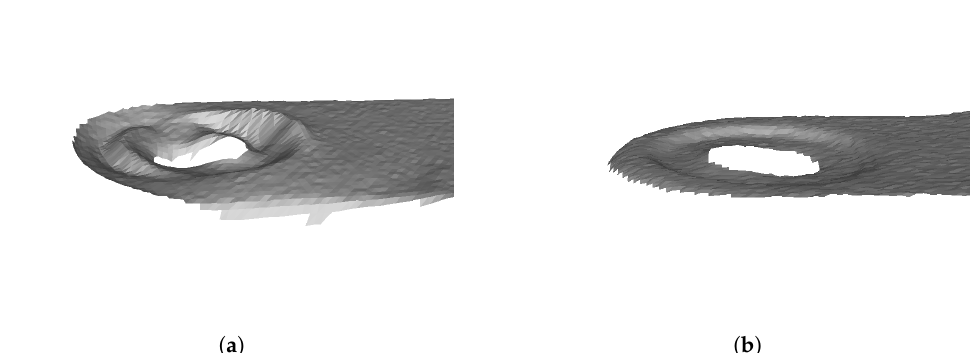
Figure 10. The effects of reflection in the structured light shape acquisition procedure. ( a ) Without dry powder reflections cause geometry errors. ( b ) With dry powder the obtained surface correctly matches the